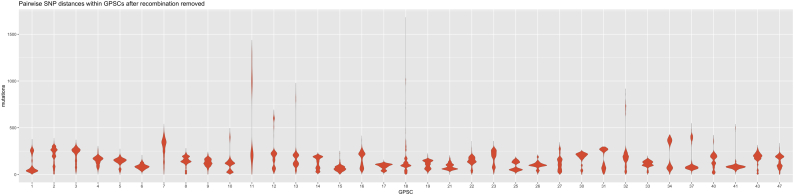
Pairwise SNP distances within dominant-GPSCs.Violin plots of pairwise SNP distances within the 35 dominant-GPSCs after recombination removed from an alignment from mapping to an internal reference for each GPSC are largely comparable.